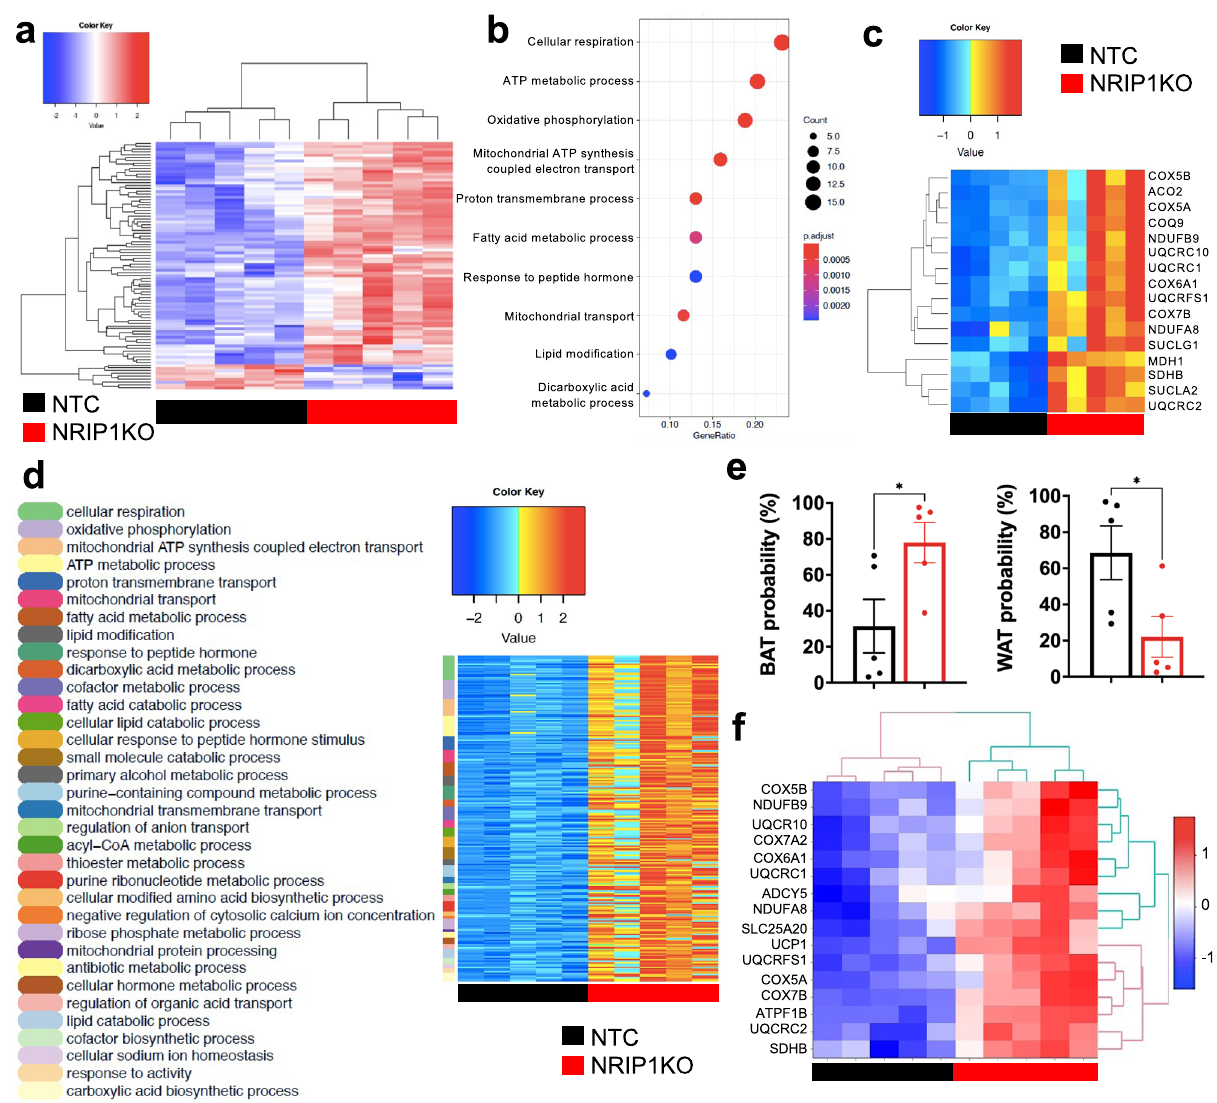
Fig. 6 RNA sequencing on human NTC and NRIP1KO mature adipocytes on day 7 after differentiation. a Heatmap of all differentially expressed genes between NTC and NRIP1KO based on normalized read counts. b Top 10 pathways associated with all upregulated genes detected. c Heatmap of genes associated with cellular respiration that were upregulated in NRIP1KO adipocytes. d Heatmap of pathway analysis of upregulated genes ranked by the were found highly expressed in the NRIP1KO samples compared to the NTC. Cut-offs were set at padj < 0.1 and fold change > 1.3. NTC ( n = 5),